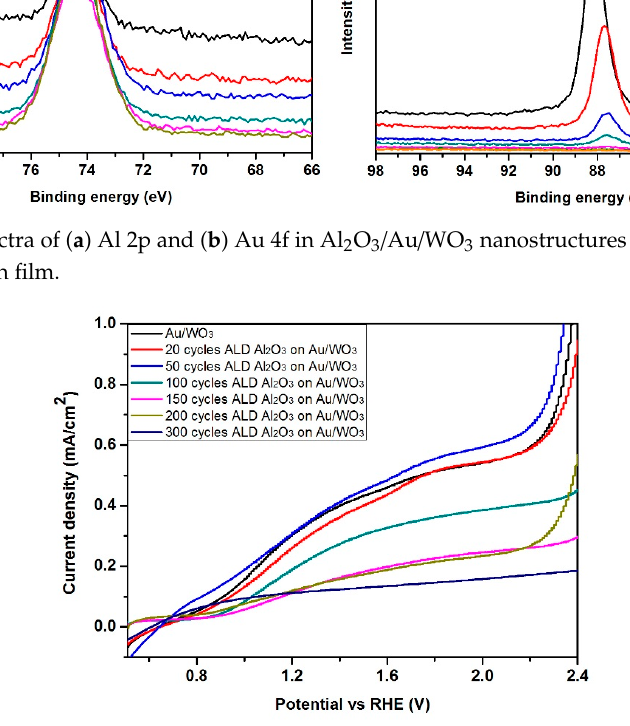
Figure 10. J-V curves of Al 2 O 3 /Au/WO 3 during photoelectrochemical measurement.